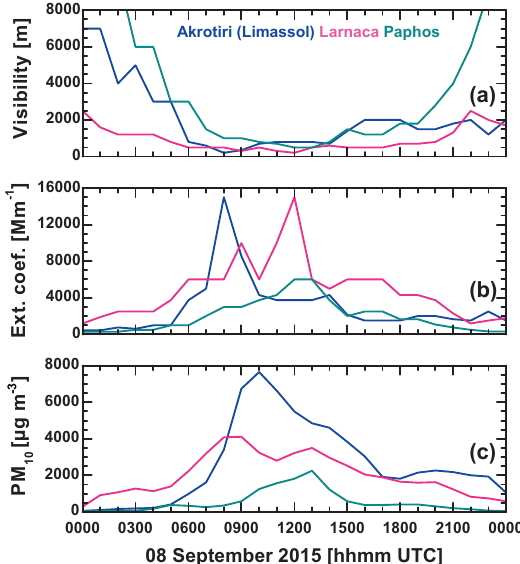
Figure 8. Visibility ( r vis in Eq. (2)) measured at three airports in southern Cyprus (see map in Fig. 7c) on 8 September 2015, (b) corresponding dust extinction coefficient (by using Eq. 2), and (c) PM 10 concentrations (same as shown in Fig. 7c). Relative uncer- tainties in all parameters are of the order of 50%. Dust extinction coefficients of 4000–8000Mm − 1 indicate dust mass concentrations of 6600–13300µgm − 3